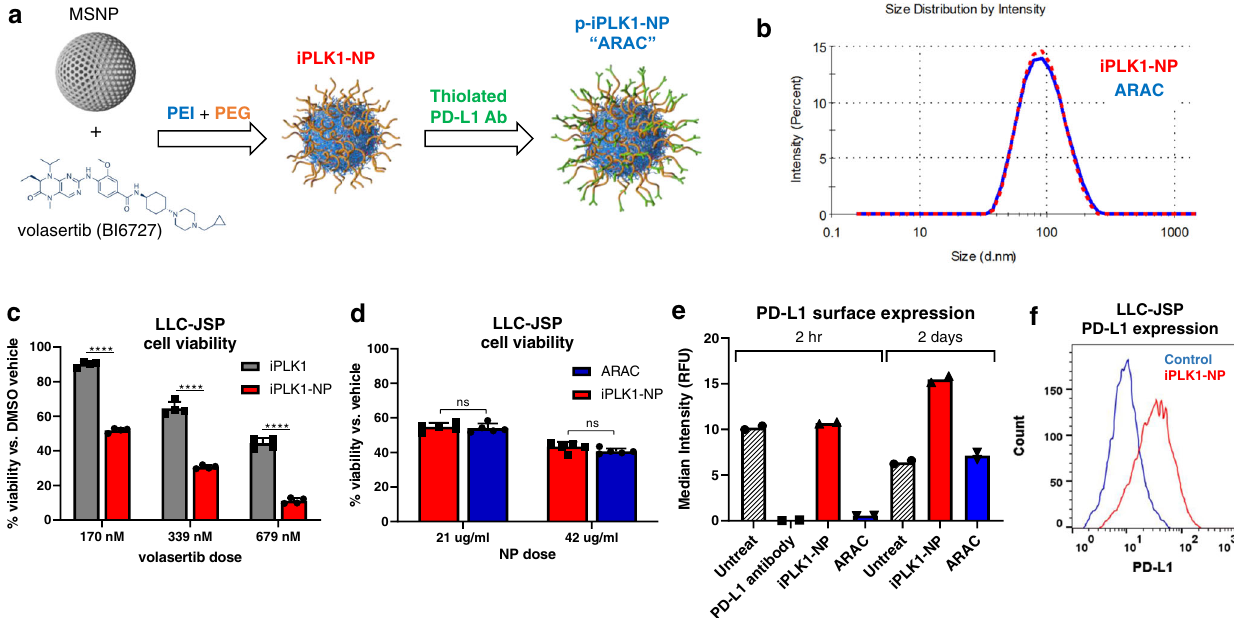
Fig. 4 PD-L1 antibody conjugated NP for delivering PLK1 inhibitor volasertib (p-iPLK1-NP; ARAC). a Synthesis scheme. Nanoparticle images are re- printed with permission from Wiley 18 ; © 2022 Wiley-VCH GmbH. b Hydrodynamic size by dynamic light scattering (DLS). c Cell viability by CTG assay of LLC-JSP cells treated with volasertib (iPLK1) or iPLK1-NP; all having equivalent volasertib dose as speci fi ed. Data presented as mean ± SD from 4 independent samples; **** P < 0.0001 (Unpaired t -test; two-tailed). d Cell viability by CTG assay of LLC-JSP cells treated with iPLK1-NP or ARAC (p-iPLK1- NP) at equivalent NP and volasertib dose. Data presented as mean ± SD from 5 independent samples; ns – not signi fi cant (Unpaired t -test; two-tailed). ( e , f ) PD-L1 surface expression of the cells treated with PBS, PD-L1 antibody (50 µ g/ml), iPLK1-NP (with 210 ng/ml volasertib), or ARAC (with 210 ng/ml volasertib and 1.68 µ g/ml antibody) for 2 h and 2 days. Data presented as mean MFI from biological duplicates, 10,000 events collected per sample. Source data are provided as a Source Data fi 4T1 cells (with upregulated PD-L1). As shown in Supplementary